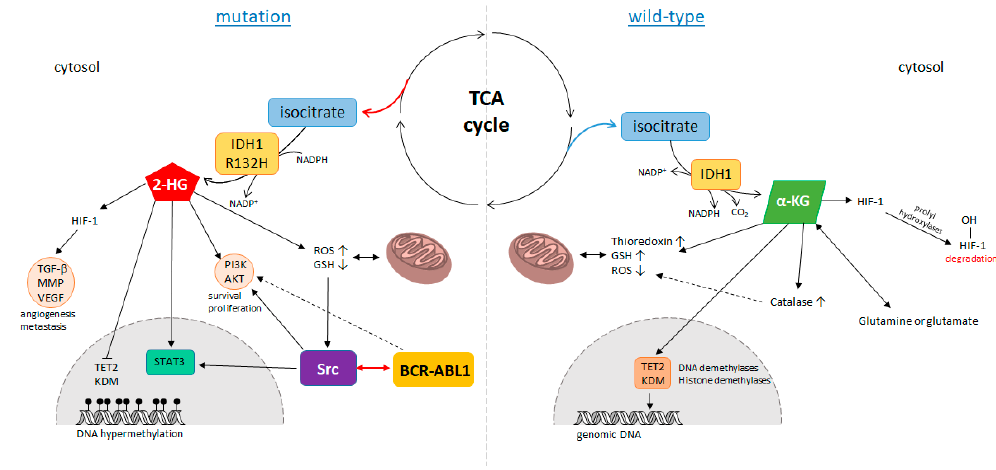
Figure 1. Comparison of the function of the IDH1 enzyme (wild ‐ type) and its mutated form IDH1 Figure1. R132H.